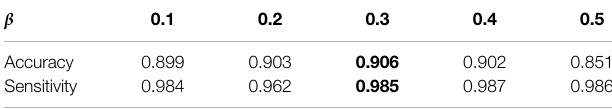
TABLE 4 | DR classi fi cation results using different β on the APTOS 2019 dataset.